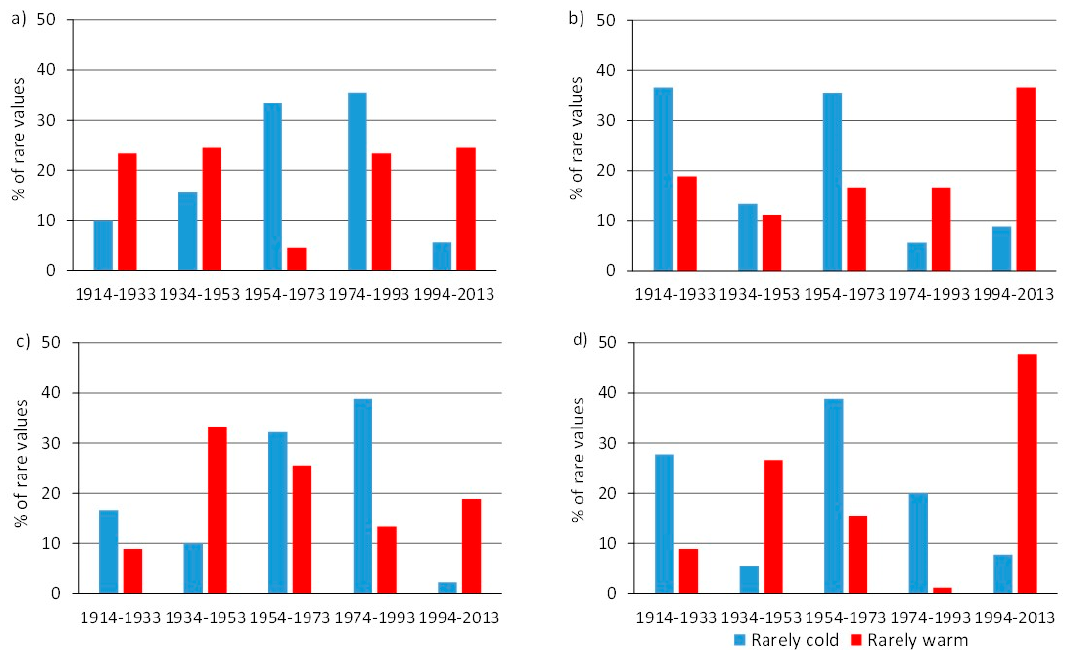
Figure 3. The total proportion of rarely cold and warm seasons (10th and 90th percentile of mean seasonal temperatures defined separately for each weather station) observed in 20-year study intervals in northern Fennoscandia. ( a ) December-February, ( b ) March–May, ( c ) June-August, and ( d )